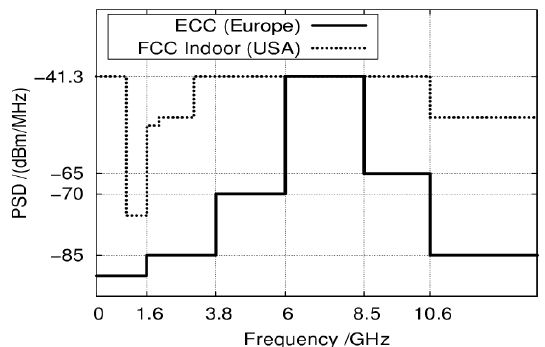
Figure 17. Vital signs retrieval algorithm for the ultra-wideband (UWB) radar in ( a ) [140] and ( b ) [131].